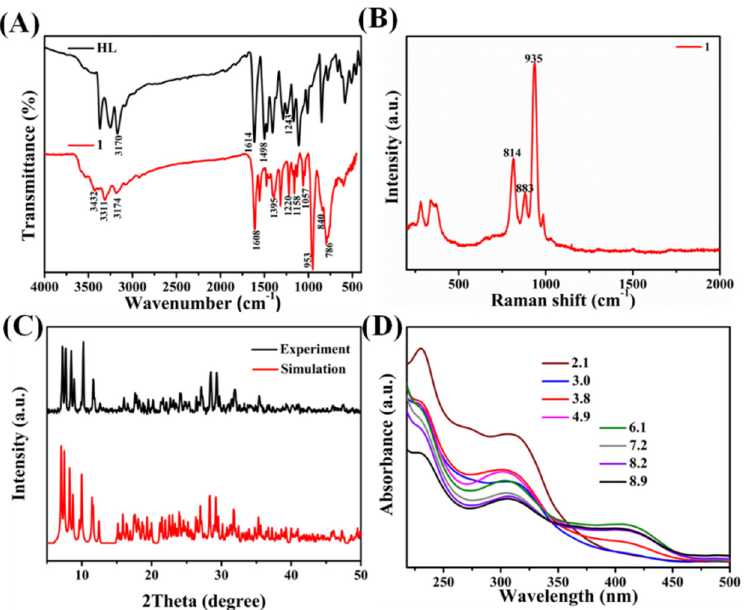
Figure 2. ( A ) Infrared spectra of 1 . ( B ) Raman spectroscopy of 1 . ( C ) PXRD pattern of 1 and ( D ) UV − Vis spectra of 1 (numbers represent the pH value).